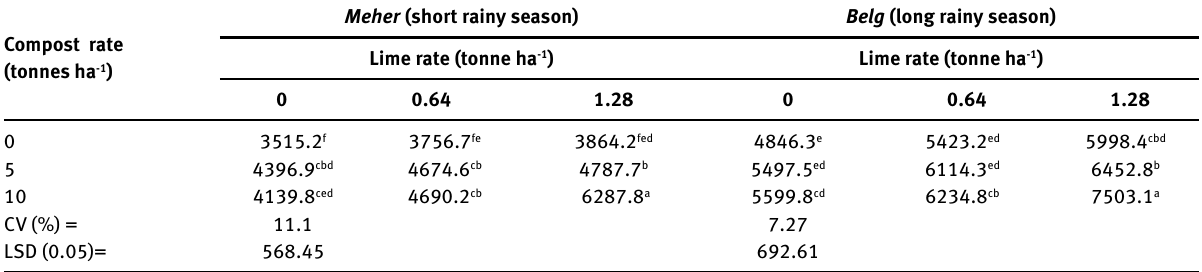
Table 7. Interaction effect of compost and lime on aboveground dry matter yield during short and long rainy season Compost rate